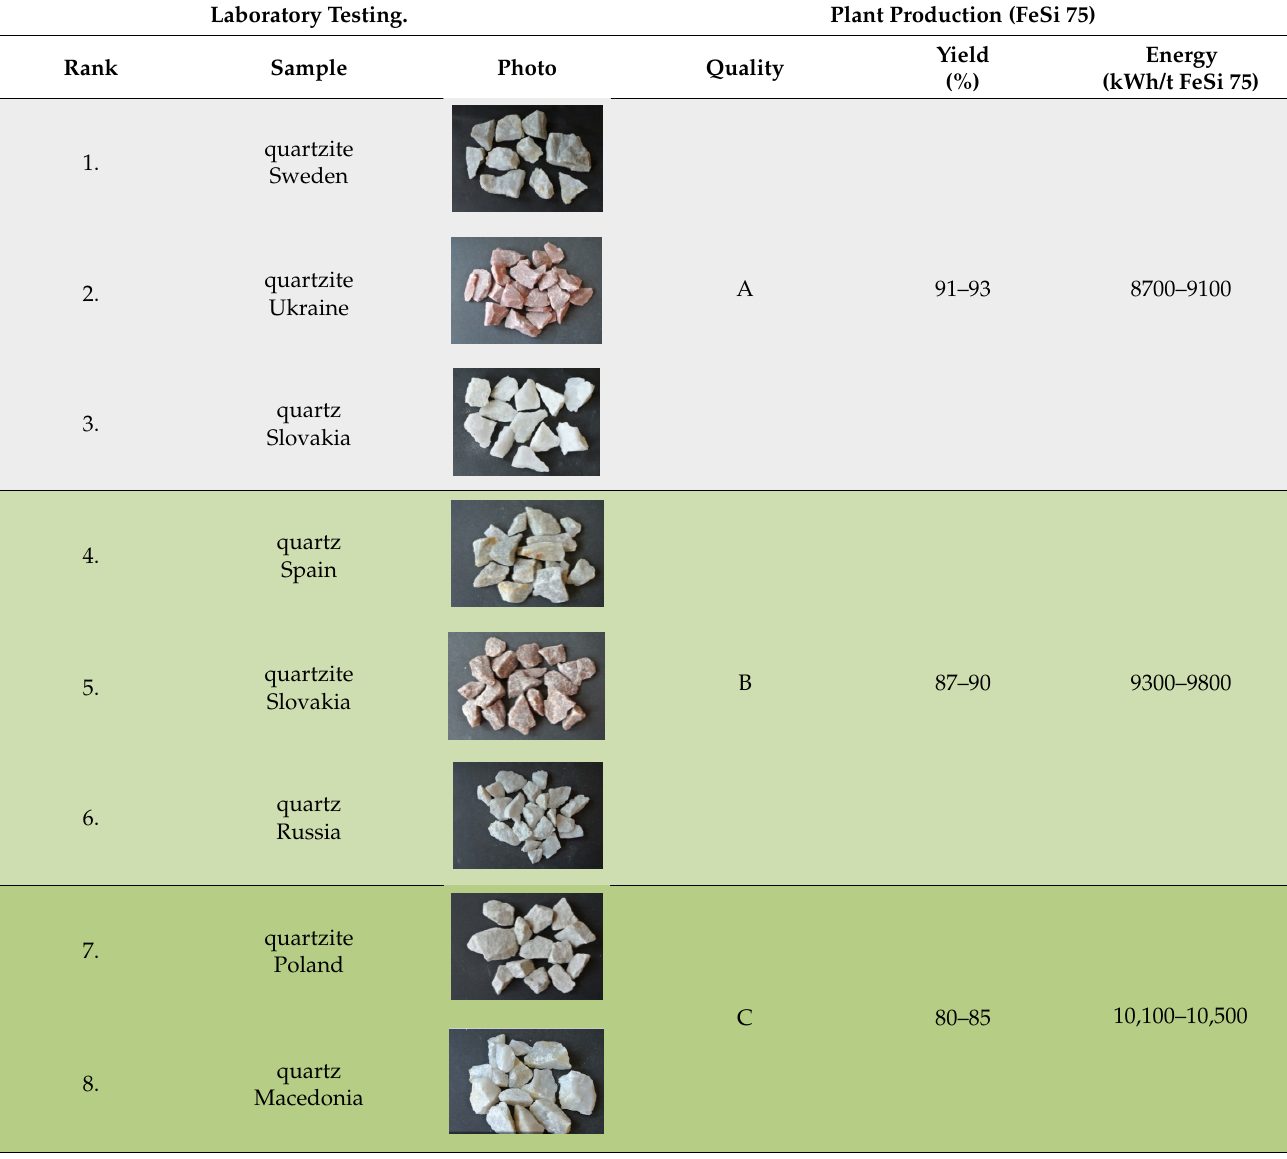
Figure 13. Microstructure comparison of silicon carbide formed in the tests: quartzite Ukraine ( a ), quarzite Slovakia ( b ), quartz Spain ( c ), and in the industrial EAF [5] ( d ). Table 10. Ranking of quartz and quartzite samples in comprehensive evaluation (according to Figure 2). Laboratory Testing.